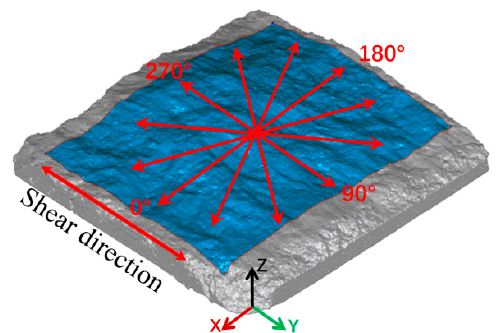
Figure 7. Schematic diagram of the analyzed directions of the roughness